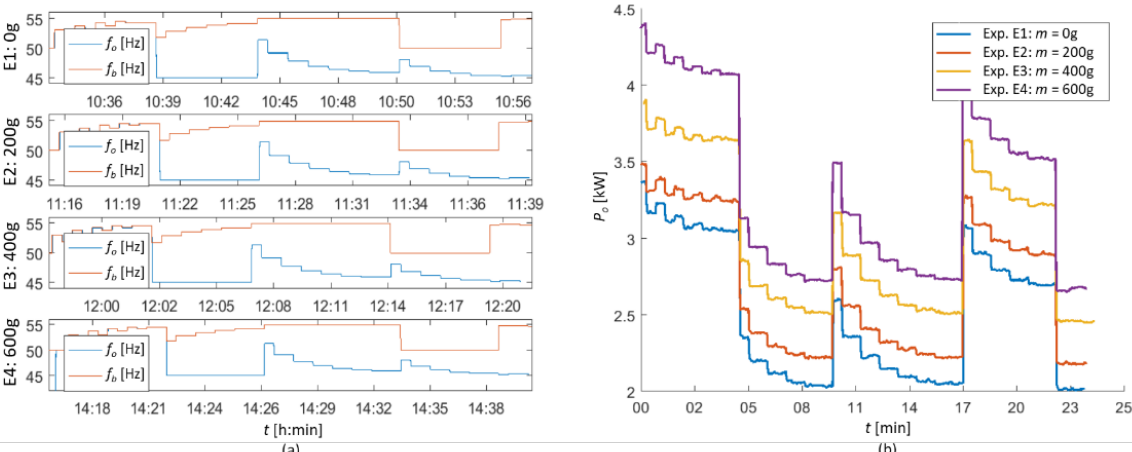
Figure 14. Results of experiments for various mass of grinding medium: ( a ) changes in frequency values; ( b ) changes in the active power of the mill (objective function).